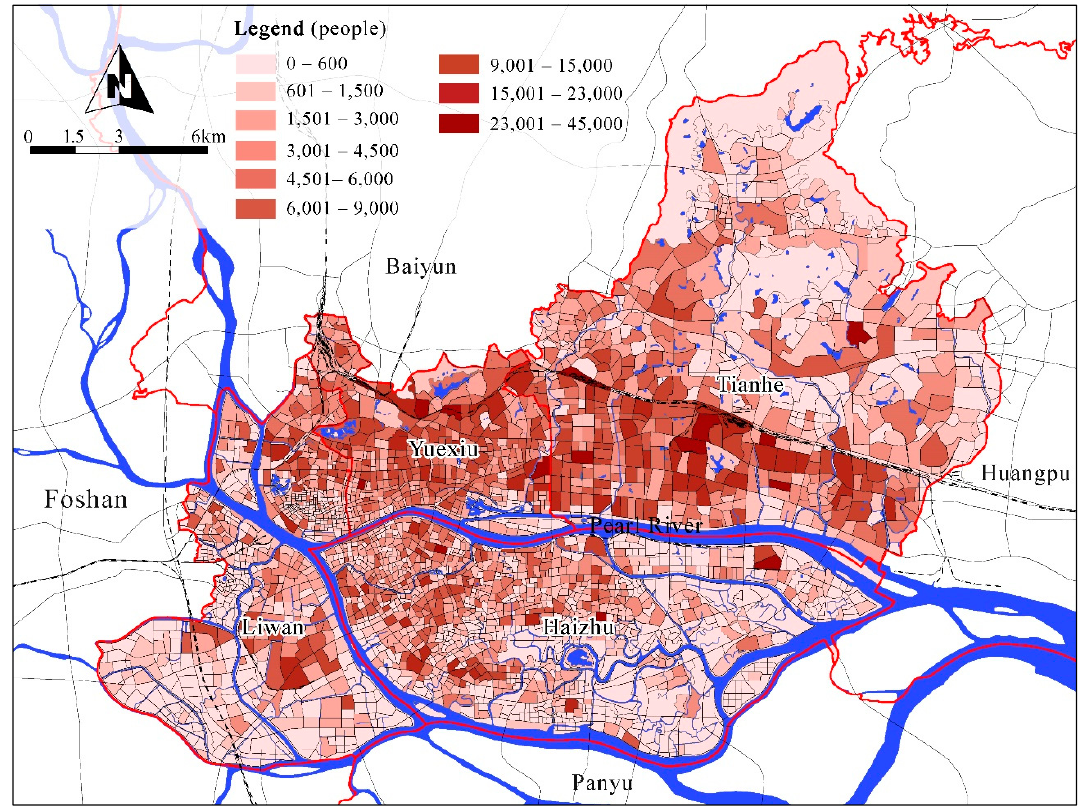
Figure 6. Distribution and size of shelter demand based on day and night disaster relief.